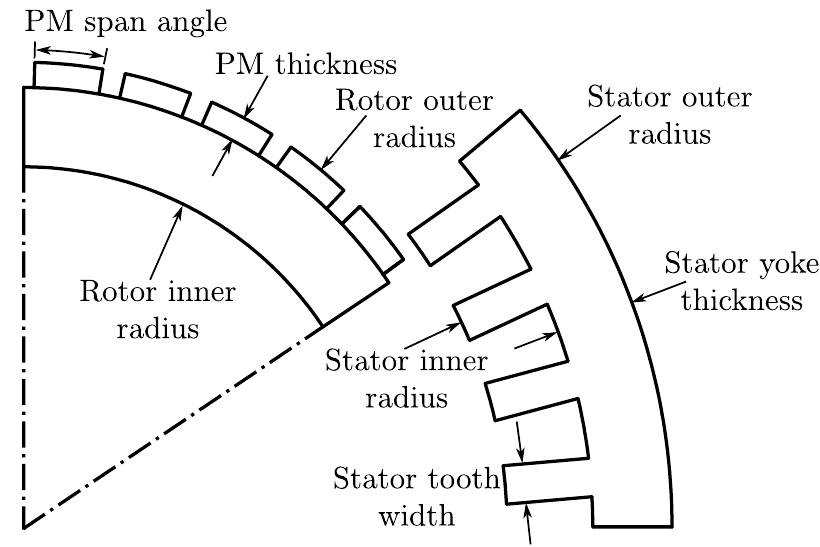
Figure 10. Design parameters of the